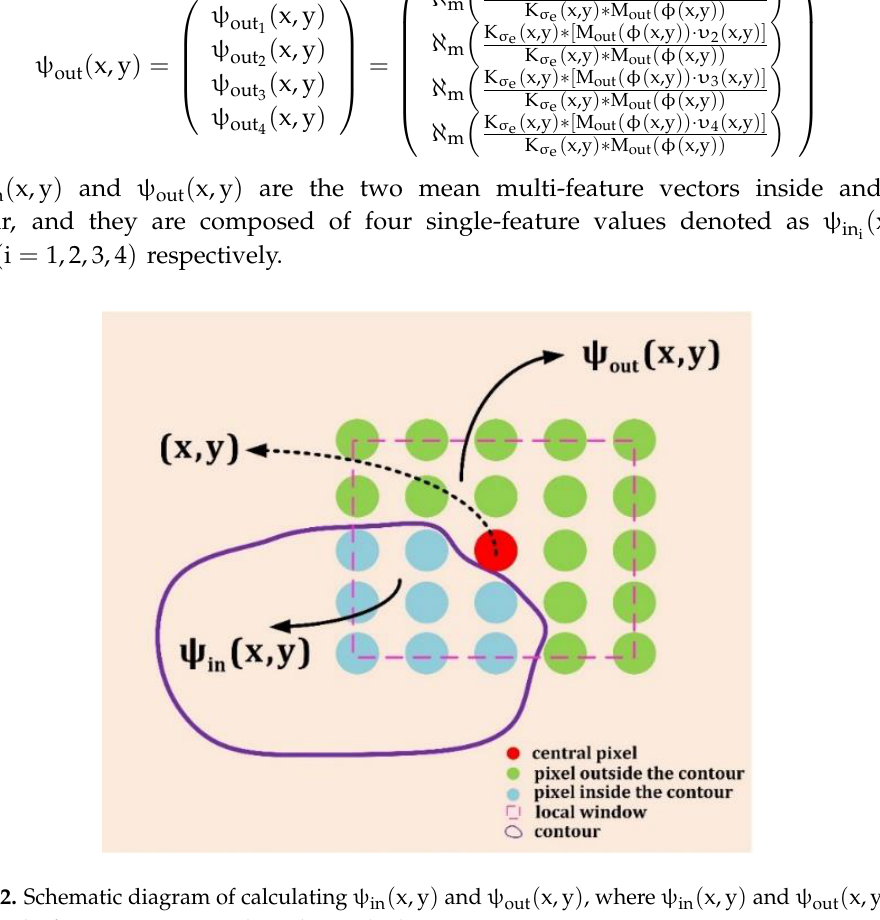
Figure 2. Schematic diagram of calculating ψ in ( x,y ) and ψ out ( x,y ) , where ψ in ( x,y ) and ψ out ( x,y ) are mean multi-feature vectors inside and outside the